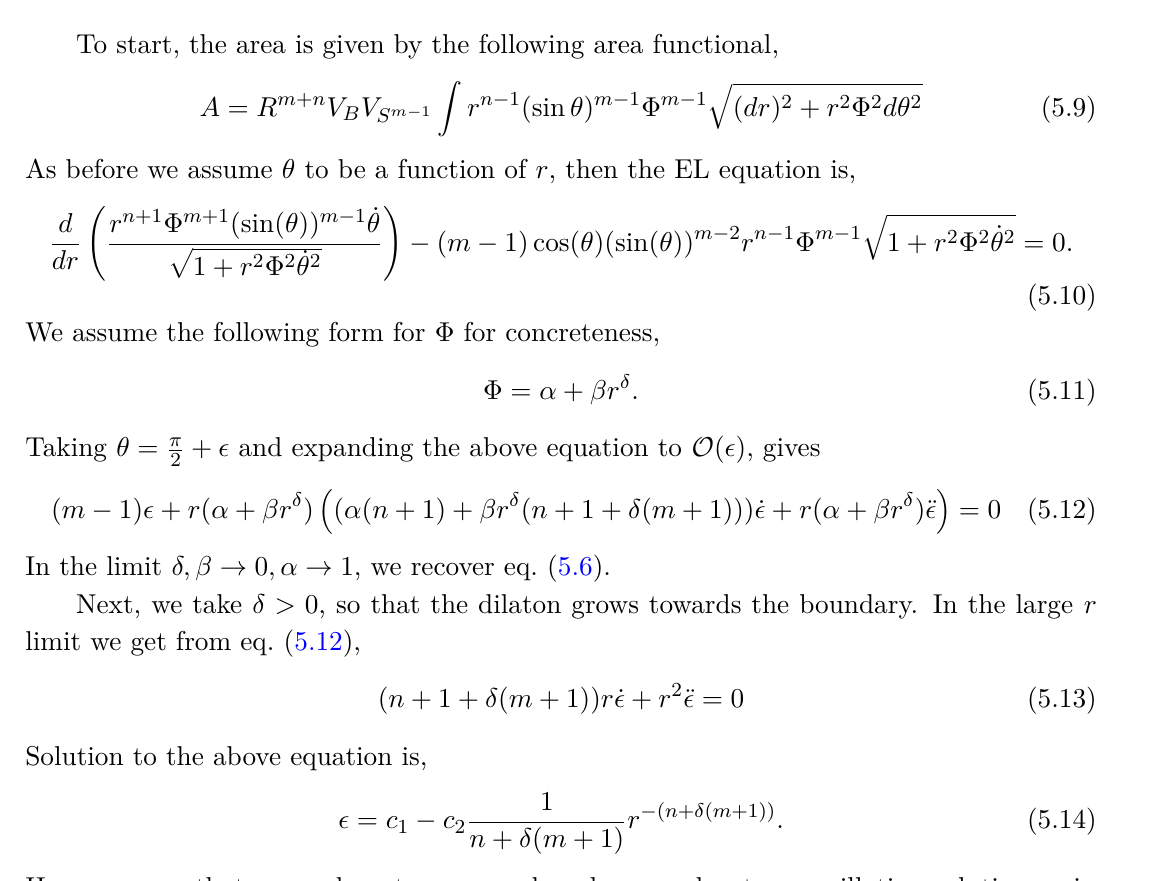
Figure 6. (a) We have plotted the difference between the value of θ and π after enhancing it by 10 7 . As is clear from the plot the maximum occurs around 8.16. (b) We have plotted the area as a function of r . We have divided the area eq. (5.1) by the value it gives at r 0 = 5 . The plot then clearly represents a function that is monotonically decreasing from 1 to 0 as r increases from r 0 = 5 to r UV = 10 4